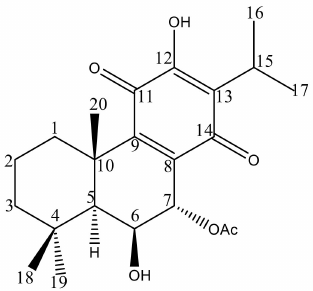
Figure 1. Chemical structure of 7 α -acetoxy-6 β